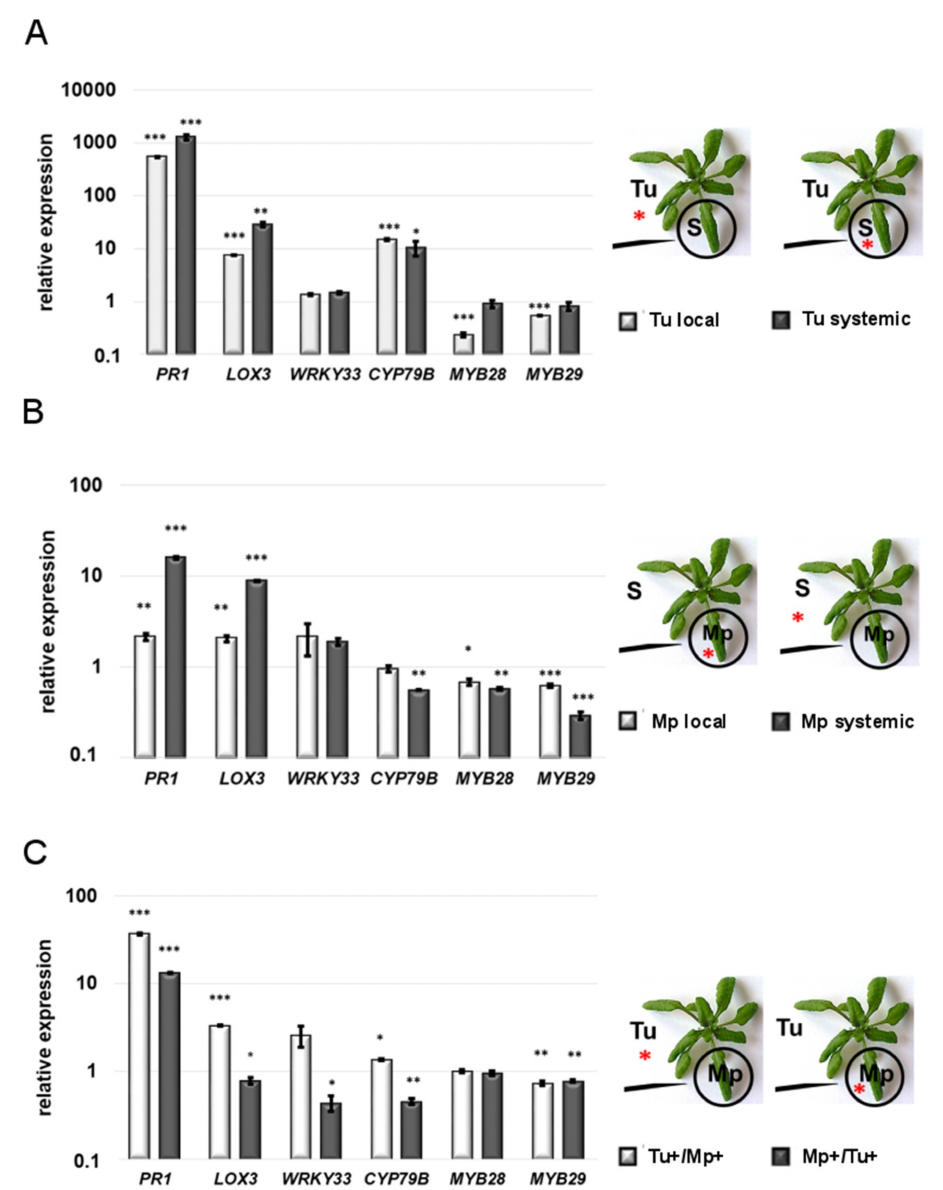
Figure 2. The comparison of defense-related gene expression in local and systemic Arabidopsis leaves upon single and simultaneous feeding of TSSM (Tu) and GPA (Mp), normalized against ACT2 mRNA level. ( A ) Single TSSM infestation. ( B ) Single GPA infestation. ( C ) Simultaneous TSSM and GPA infestation. S—systemic leaf. Red asterisks indicate leaves collected for gene expression assessment. Error bars represent standard deviation and black asterisks—*, ** and *** represent significant differences at p -values of <0.05, <0.01 and <0.001, respectively ( n = 3). The values of the relative gene expression fold changes were listed in Supplementary material (Table